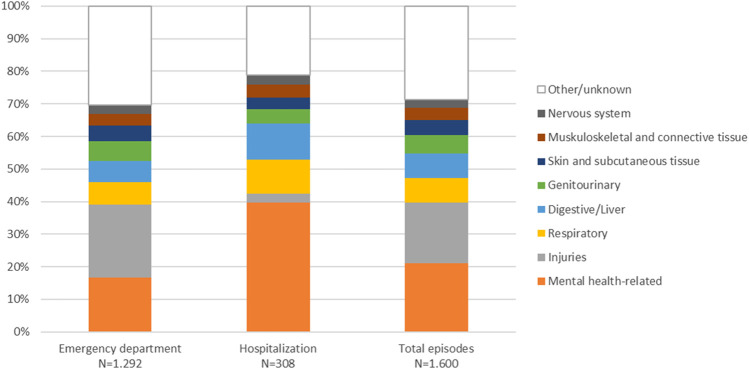
Distribution of 1,292 ED admissions and 308 hospitalizations according to ICD-10 diagnostic codes.